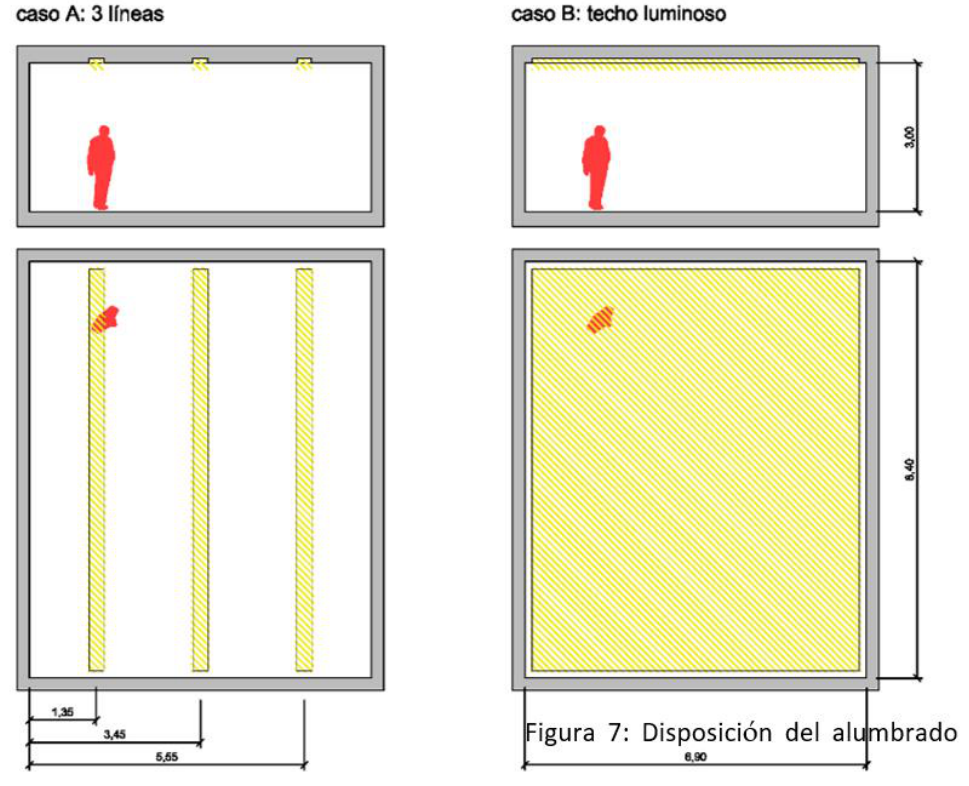
Figure 25. Linear lighting ( right ) versus surface lighting ( left ).